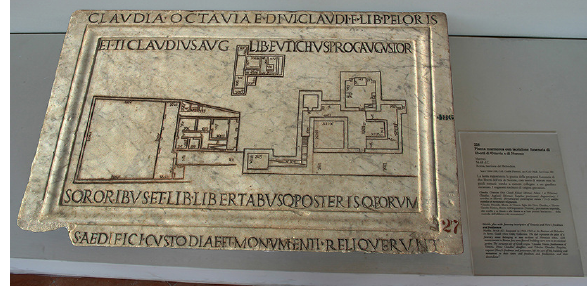
Figure 1 . Marble plan with funerary inscription of freedmen